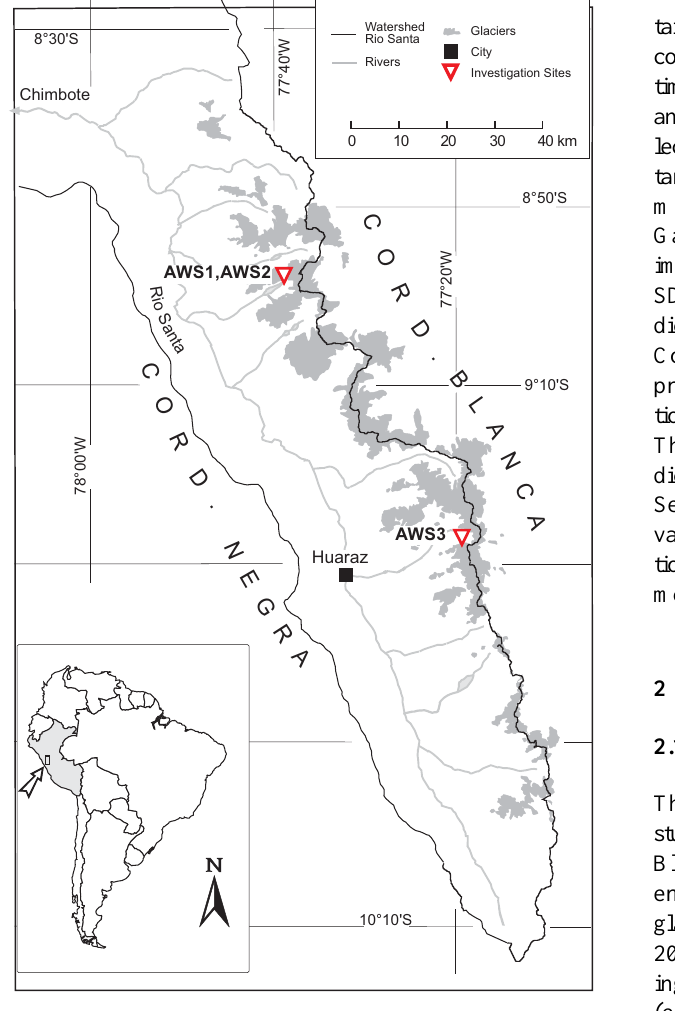
Figure 1. The map shows the Rio Santa watershed with the Cordillera Blanca mountain range and the positions of AWS1, AWS2 and AWS3 (mentioned in the text). Also indicated is the 1990 glacier extent (gray shaded area; Georges,